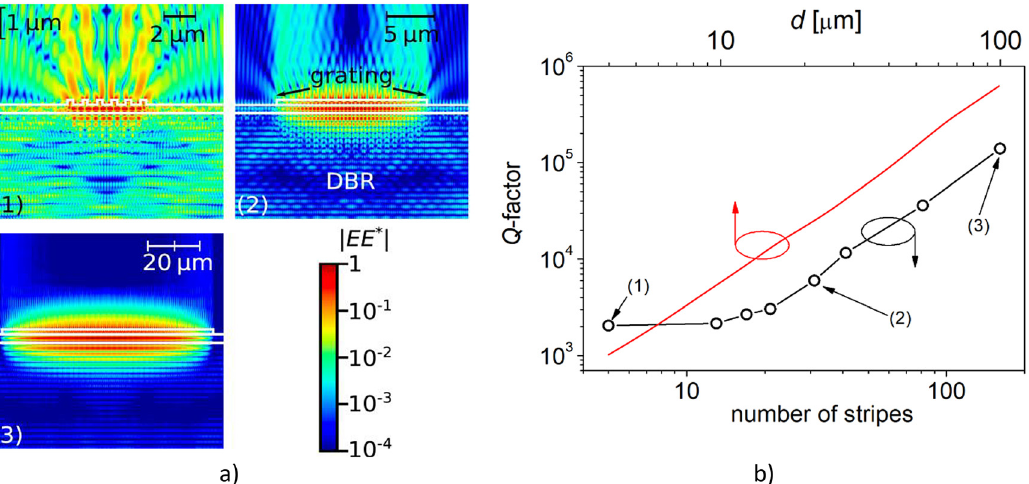
Figure 5: Light intensity distributions in the x – z plane on a logarithmic scale of colors for structures composed of 6, 20, and 100 grating stripes, indicated by numbers (1) – (3), respectively in a). Q -factor calculated in the x – z plane (black line and points) versus the number of gratingstripes(bottomhorizontalaxis)and Q -factorcalculatedinthe y – z plane(redline)versuslength( d )ofthegratingstripes(tophorizontal axis) in b). Numbers indicate the Q -factors of the structures presented in